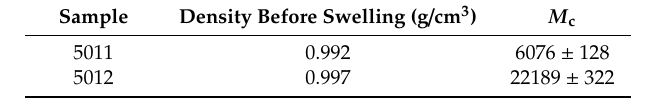
Table 2. M c value of coating.